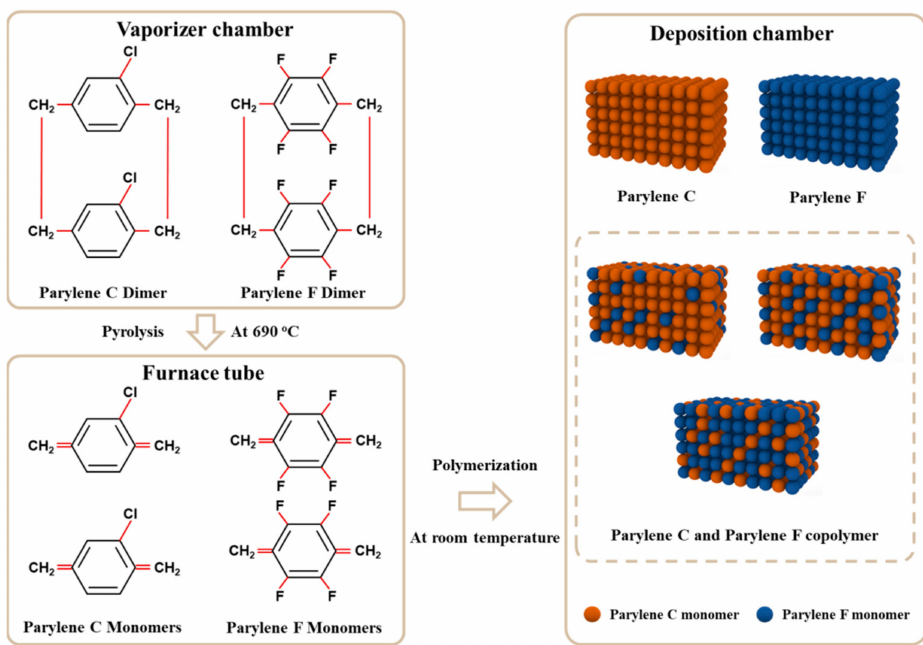
Figure 1. Deposition process of Parylene films. Parylene C and Parylene F dimers are vaporized, pyrolyzed into monomers, and polymerized in the deposition chamber. Parylene homopolymer film (C, F) and Parylene copolymer film (C and F) are